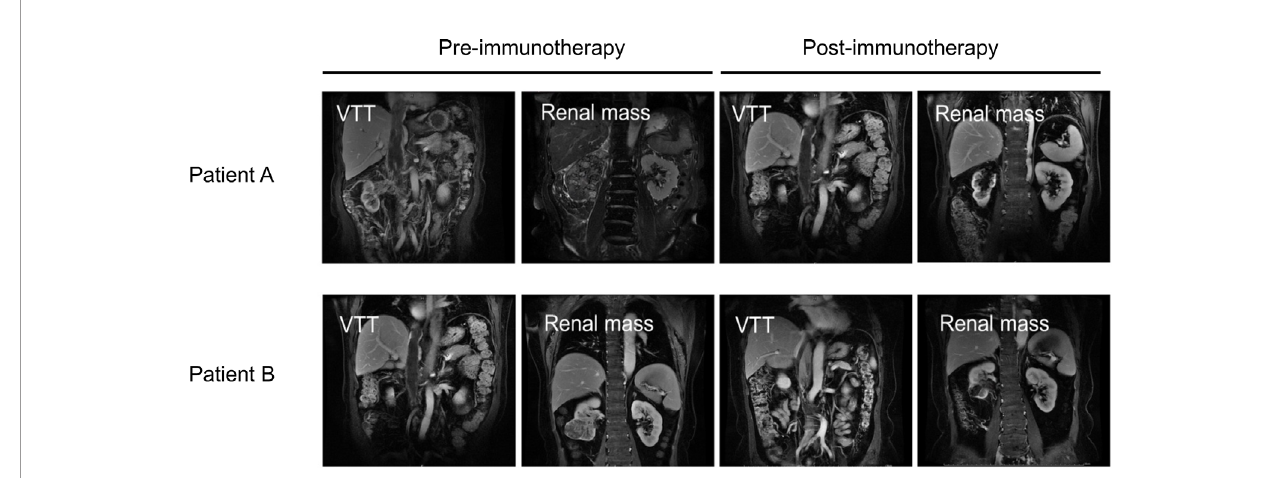
FIGURE 7 | Images of VTT and the renal mass pre- (left) or post-immunotherapy (right) of two ccRCC patients with VTT. VTT, venous tumor thrombus; ccRCC, clear cell renal cell